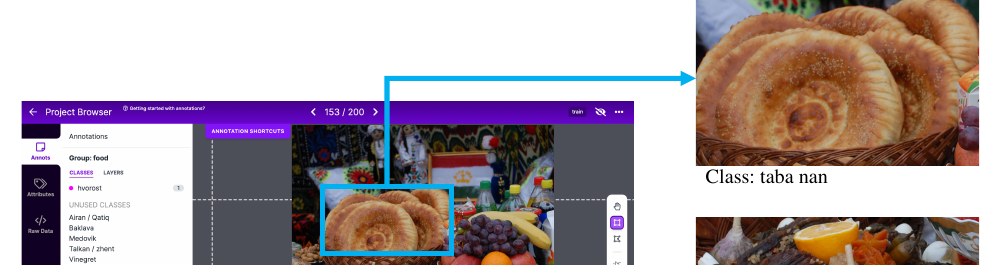
Figure 1. Sample images for Central Asian Food Dataset classes.